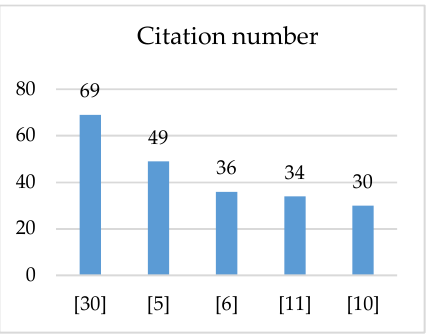
Figure 10. Research with the highest number of citations in traditional methodologies.